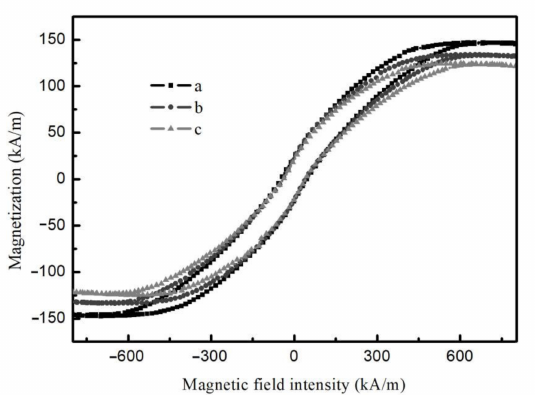
Figure 11. Hysteresis loops of different positions on alumina-Co composite film at room temperature. Curves ( a – c ) correspond to positions A to C in Figure